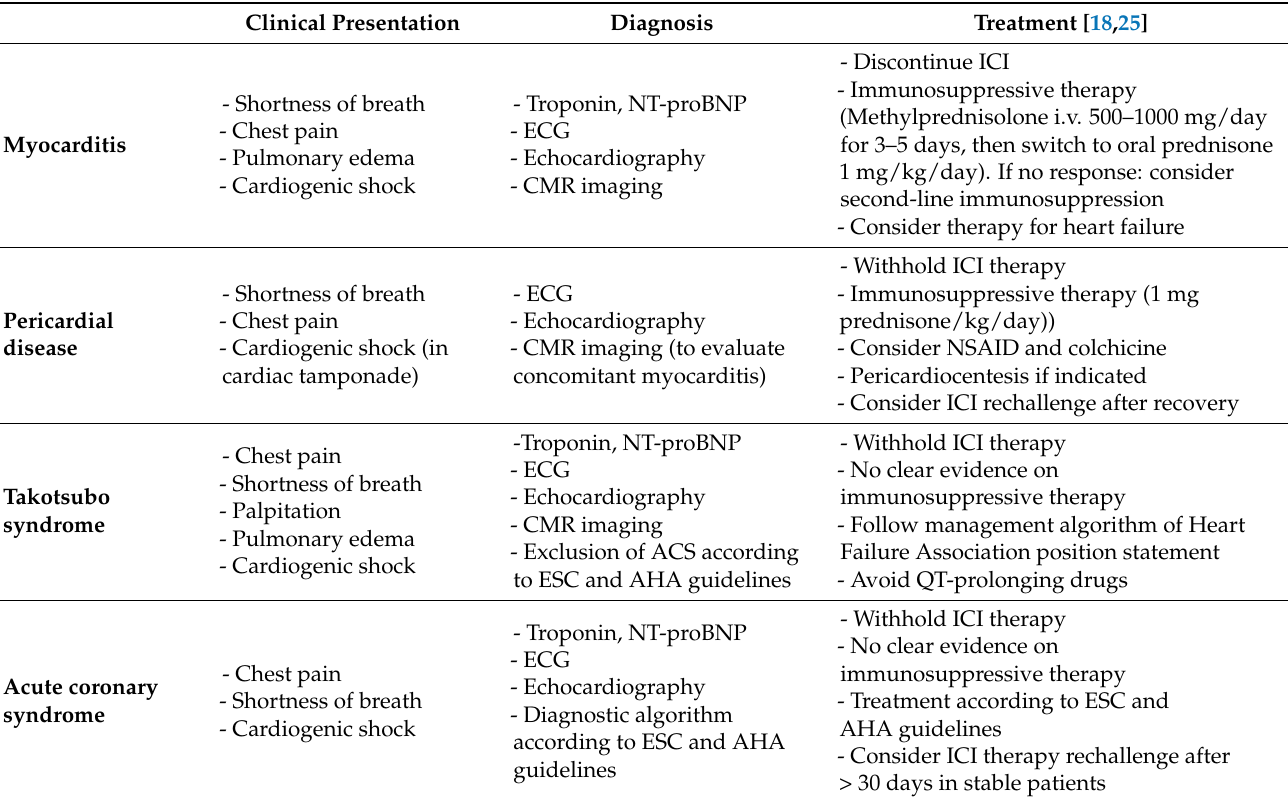
Table 3. Diagnosis and treatment of the main cardiovascular adverse events related to immune check-point inhibitors (ICIs)